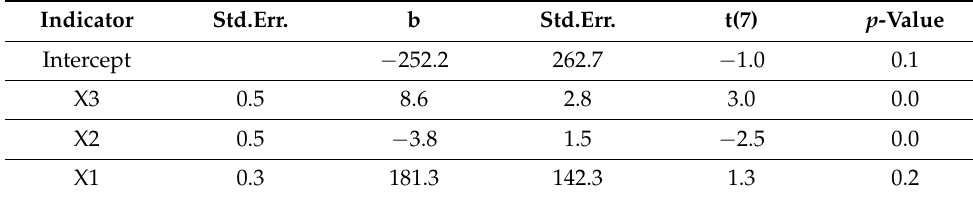
Table 5. Regression analysis results for variable Y3. Indicator